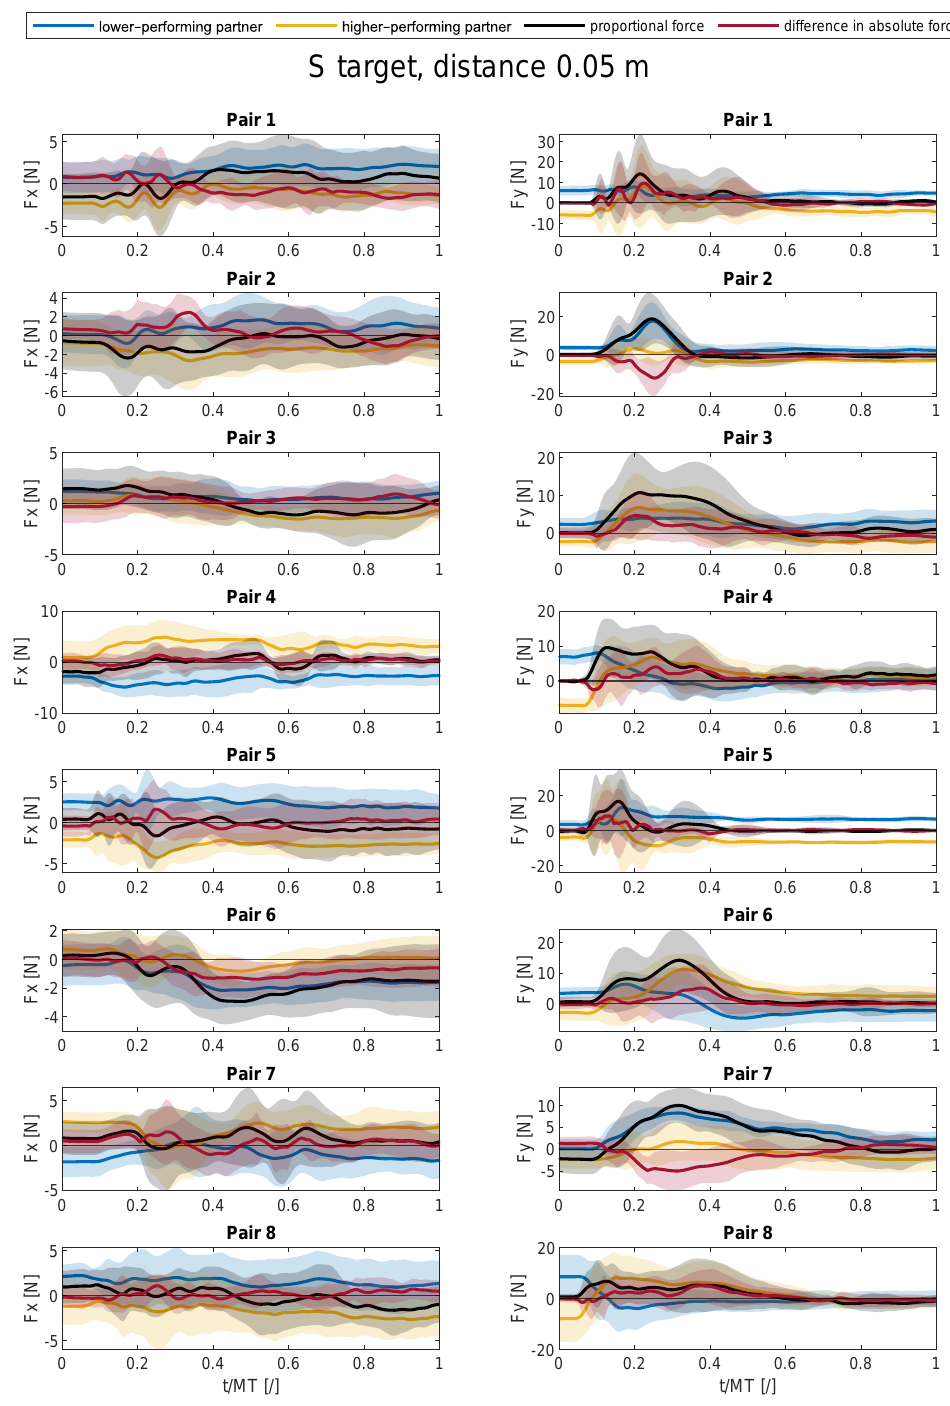
Figure A1. Average force trajectories with standard deviation (shaded area) in x- and y-direction in collaborative task for the small target at the distance of 0.05